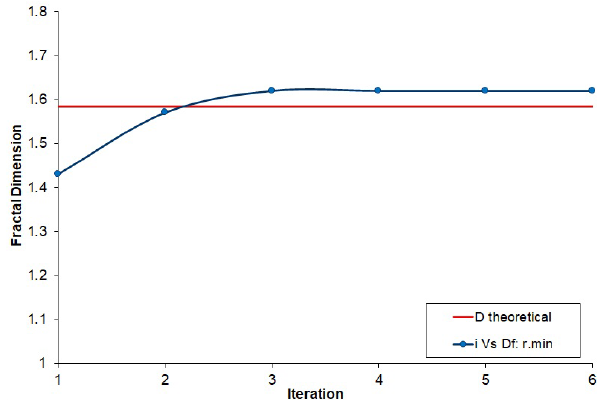
Figure 2. Variation of box-counting fractal-dimension with itera- tion for networks, i = 1–6 (modified from Roy et al., 2007).